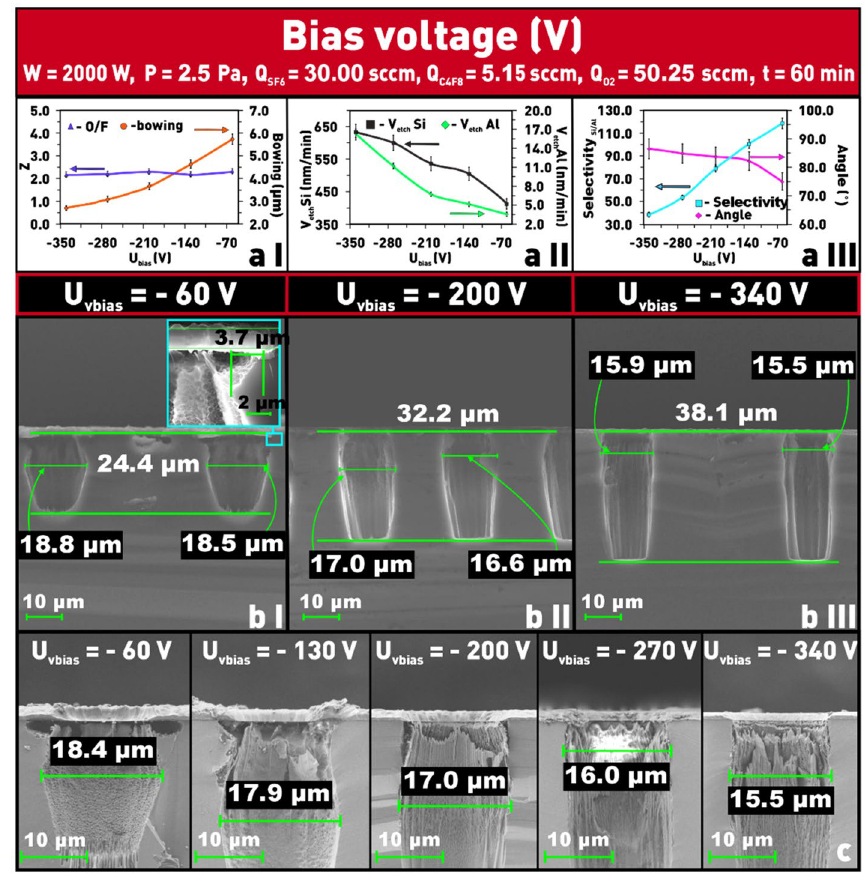
Figure 9. Dependences on bias voltage: ( a I ) of δ and Z parameters; ( a II ) of etching rate of silicon and aluminum; ( a III ) of etch selectivity and angle Θ; ( b I – III ) microphotographs of etch window profiles at different values of bias voltage; ( c ) microphotographs of etched windows at different values of bias voltage in SF 6 /C 4 F 8 /O 2 plasma to evaluate the structure overetching